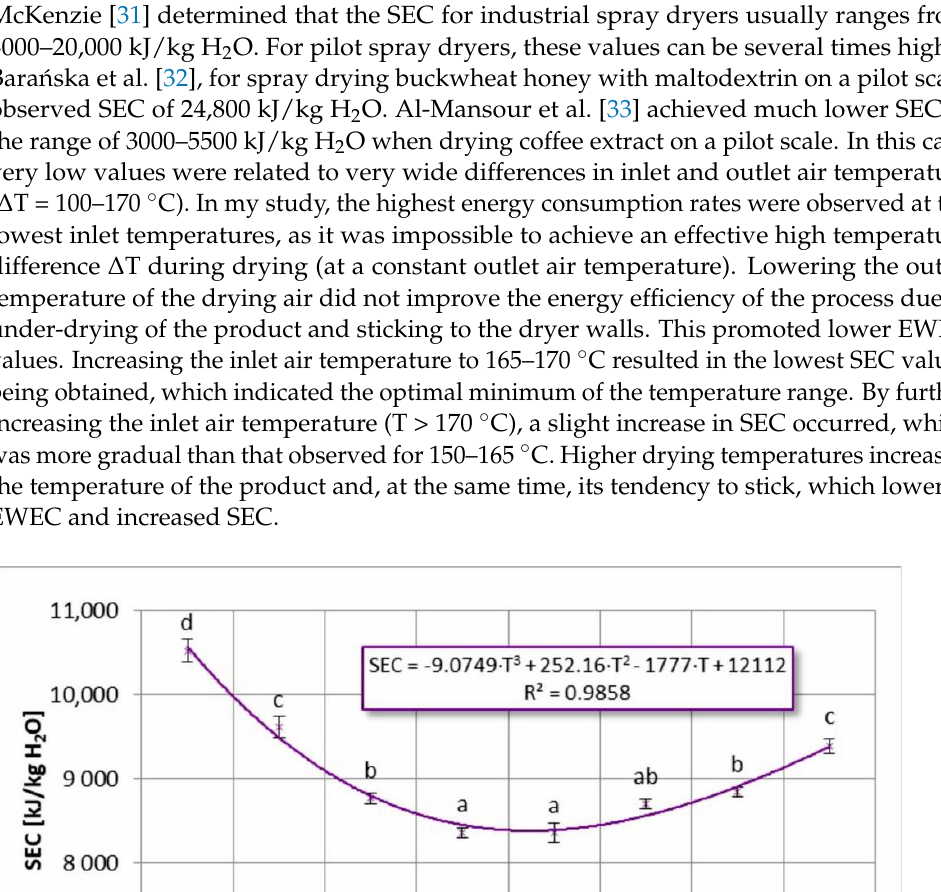
Figure 8. Specific energy consumption (SEC) in the process of spray drying chokeberry juice with different dry matter content in the feed solution (U d.m. ); (a, b, c, d, e — different letters show signifi- cant differences between mean values ( p ≤ 0.05)).